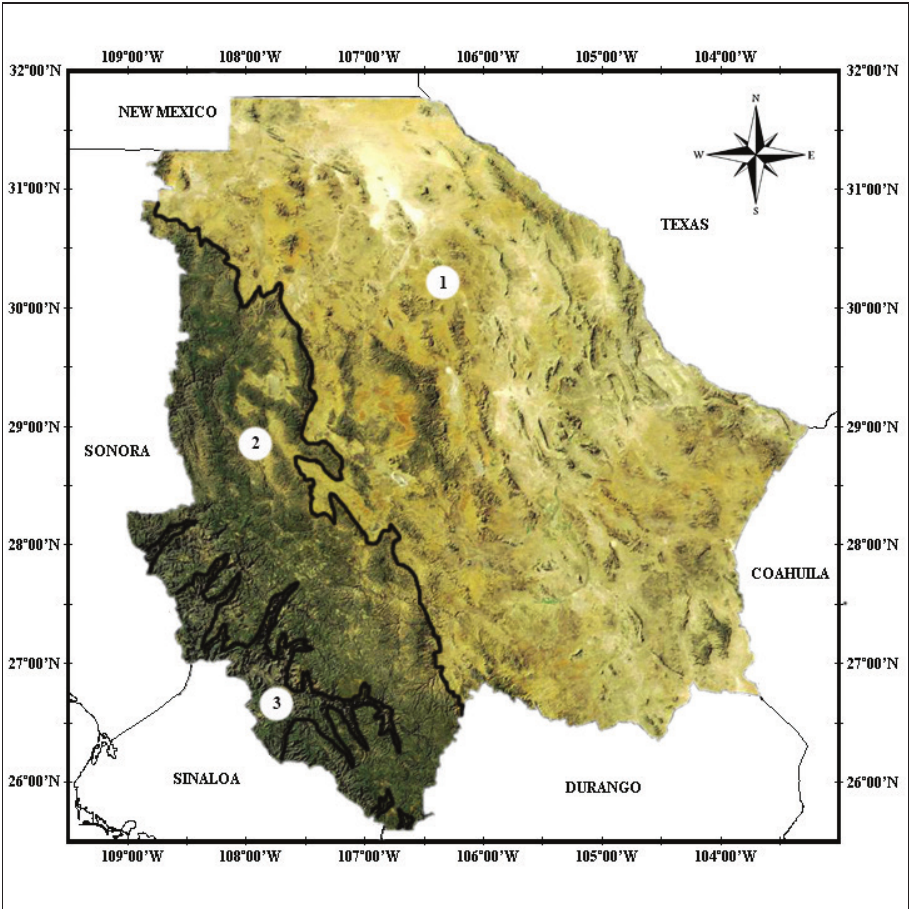
Figure 1. Topographical map of the state of Chihuahua, Mexico: 1 Chihuahuan Desert 2 Sierra Madre Occidental, and 3 Cooper Canyon (INEGI